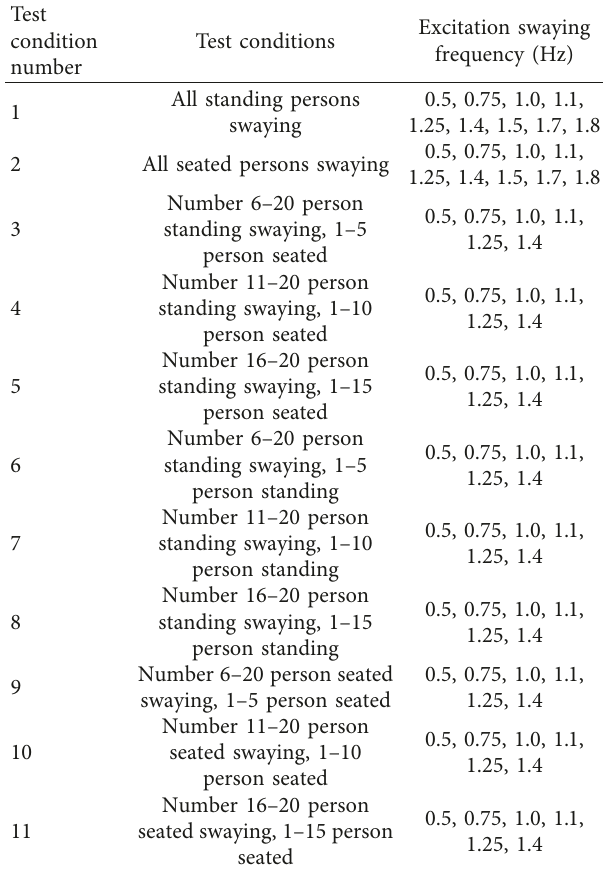
Figure 11: The natural frequency of structure when the standing person is Table 8: Conditions of crowd swayed at structure.